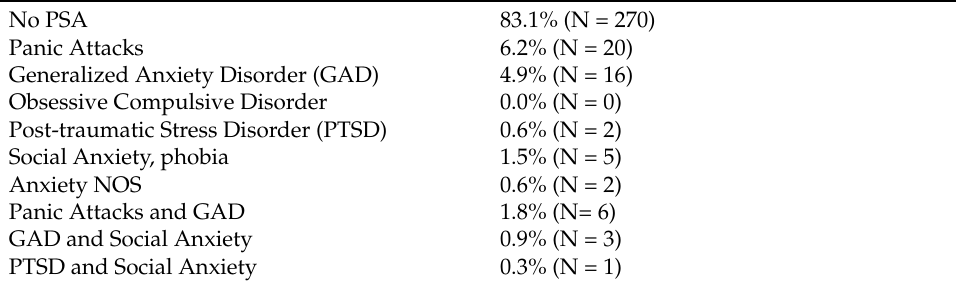
Table 2. Types of poststroke anxiety disorders in the